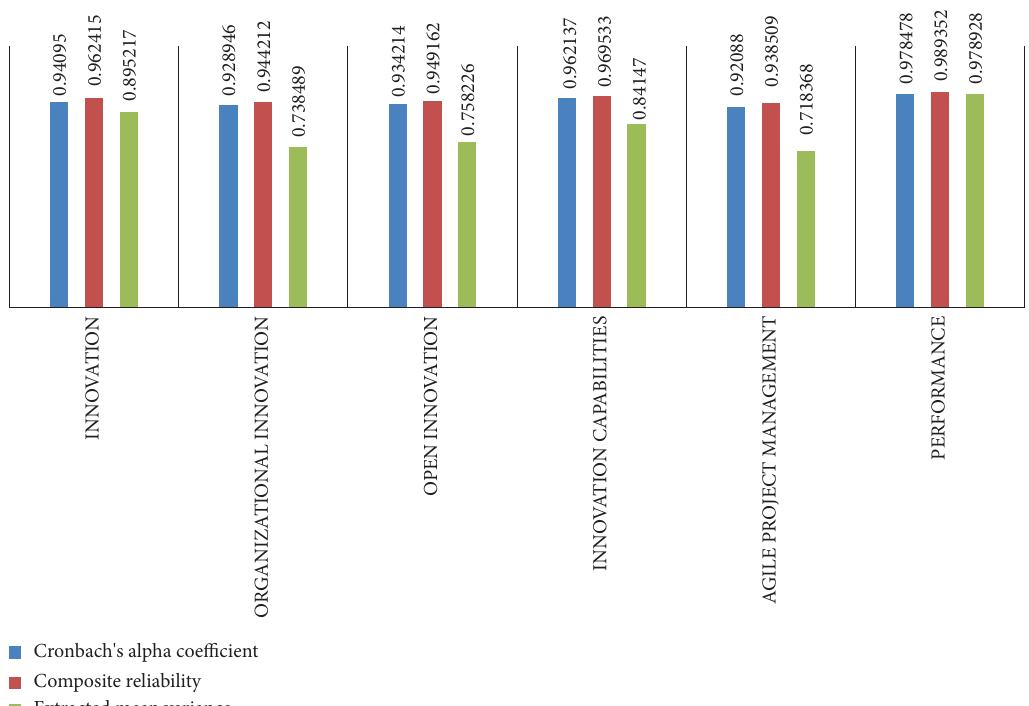
Figure 5: Cronbach’s alpha coefcient values, composite reliability, and extracted mean-variance (made by researchers). Table 6: Cronbach’s alpha coefcient values, composite reliability, and extracted mean-variance (made by researchers). Element Cronbach’s alpha coefcient Composite reliability Extracted mean-variance